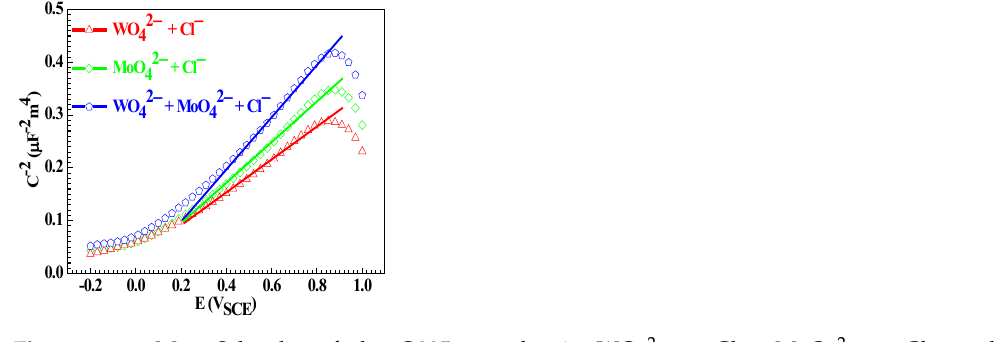
Table 5. Fitted values of N D and U f for Q235 carbon steel in WO 4 2− + Cl − , MoO 4 2− + Cl − and WO 4 2− + MoO 4 2− + Cl − solutions.